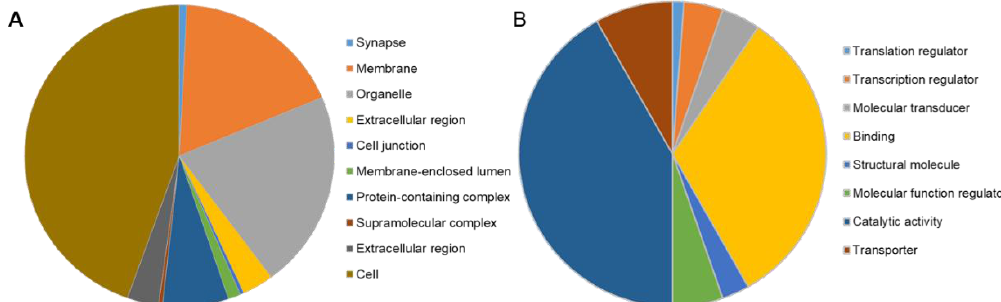
Figure 10. PANTHER Gene Ontology annotation analysis [58]. The distribution of gene ontology (GO) terms was categorized based on PANTHER GO-Slim. ( A ) Cellular Component GO terms (components of cells or extracellular) with 538 component hits. ( B ) Molecular Function GO terms (basic activities of a gene product at the molecular level, such as binding or catalysis) with 170 function hits.